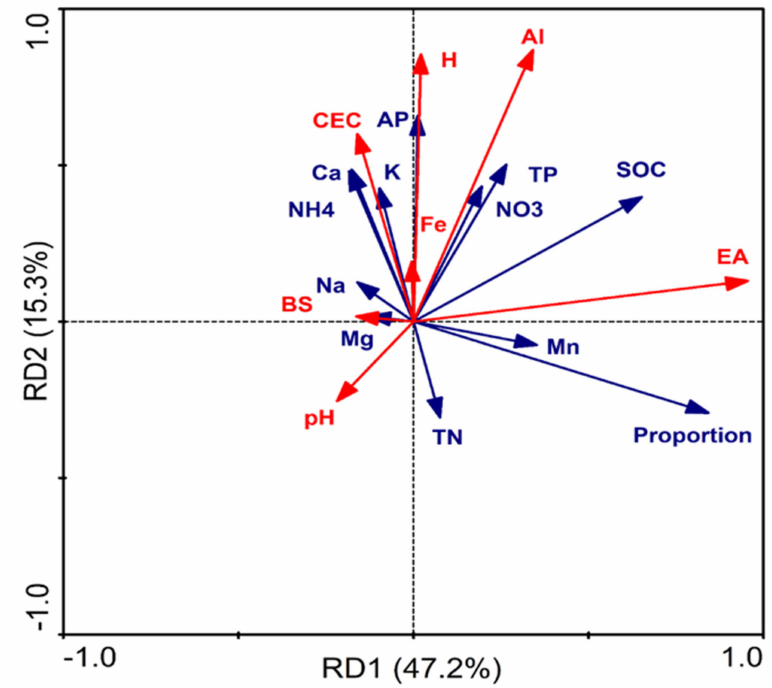
Figure 5. The redundancy analysis (RDA) for soil properties from 0–20 cm soil depths in three repli- cations at mixed broad-leaved Korean pine forest (BKPF) and artificial Korean pine forest (KPP), at four combined (NP) levels of fertilization (CK, 0 g N, and P), i.e., low (5 g N m − 2 a − 1 ; 5 g P m − 2 a − 1 ), Hydrogen ions (H); potassium ions (K); magnesium ions (Mg); manganese ions (Mn); sodium ions (Na); calcium ions (Ca); aluminum ions (Al); iron ions (Fe); effective cation exchange capacity (ECEC); base saturation percentage (BS); effective acidity (EA); ammonium (NH 4+ -N); nitrate (NO 3 − -N); total nitrogen (TN); soil organic carbon (SOC); and total phosphorus